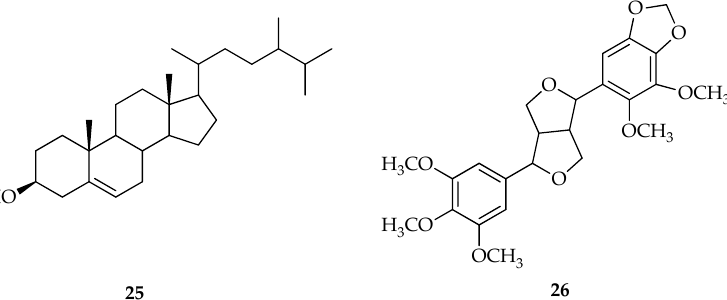
Figure 6. Compounds obtained from the methanolic extract of red betel leaf ( P. crocatum Ruiz and Pav). ( 25 ) β -sitosterol and ( 26 ) 2-(5 ′ ,6 ′ -dimethoxy-3 ′ ,4 ′ -methylenedioxyphenyl)-6-(3 ″ ,4 ″ ,5-trimethox- yphenyl)-dioxabiclo [3,3,0] octane.